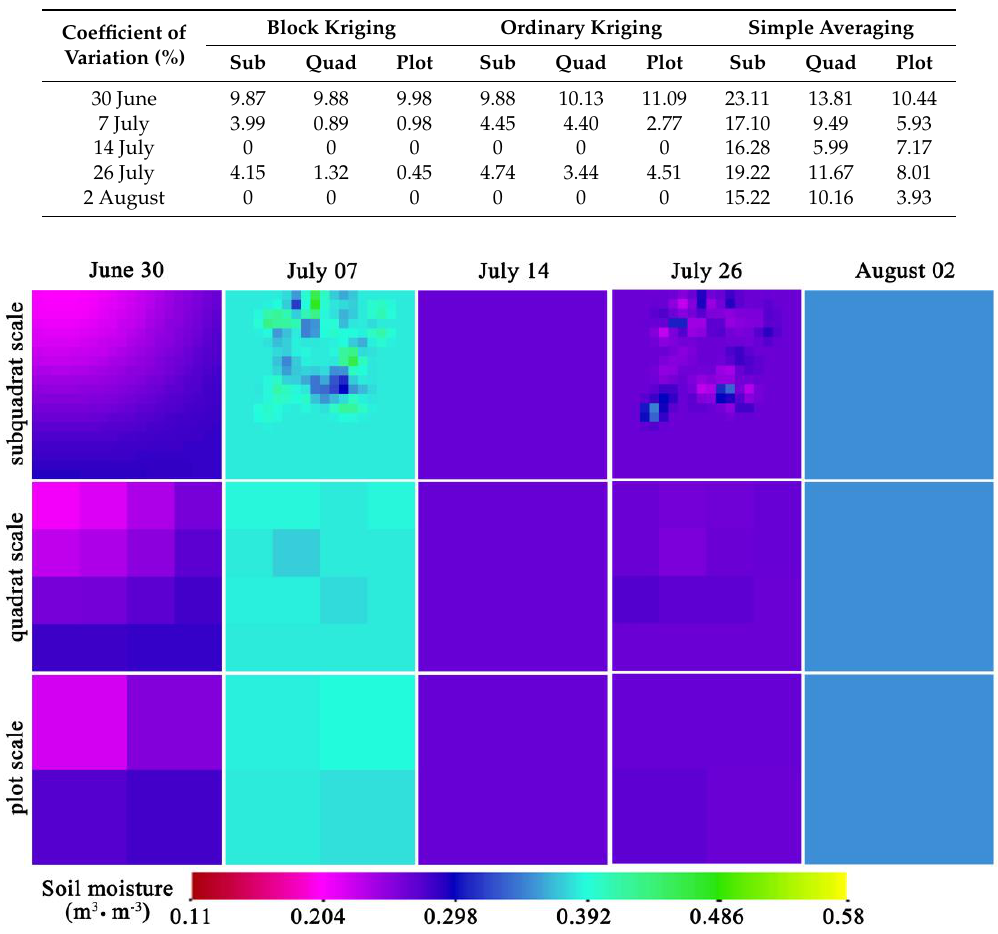
Figure 6. Upscaled soil moisture estimations at the scale series by block kriging on five acquisition days.